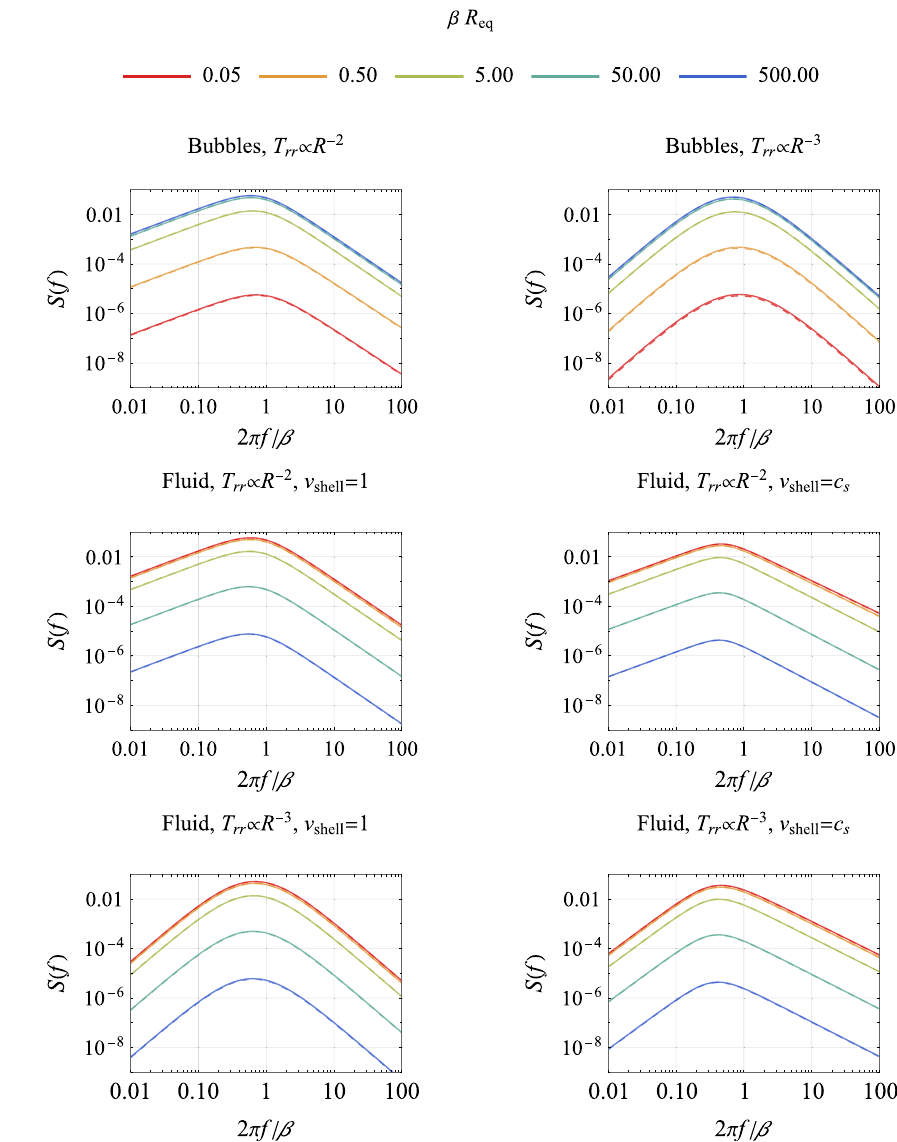
Fig. 4 Fitted GW spectral shape sourced by bubble walls and fluid motion assuming different scalings of the source after the collisions, T rr ∝ R − ξ , and different velocities of the fluid shell after the collision. The solid curves show the results obtained by directly including the factor κ( R ) to the simulation and the dashed curves the result obtained by scaling the result obtained without it factor by κ( R eff